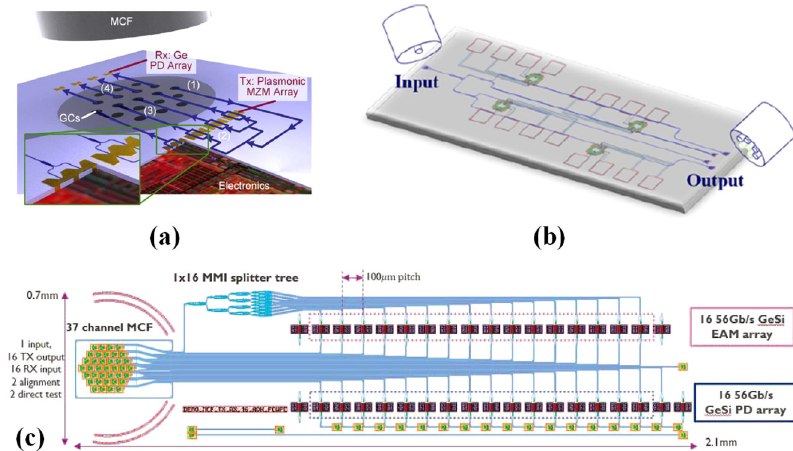
Figure 25: (a) Schematic of an 80 Gb/s optical interconnect where 9 cores of a 19-core fi ber were utilized: one core for CW input,4 coresfortransmitter